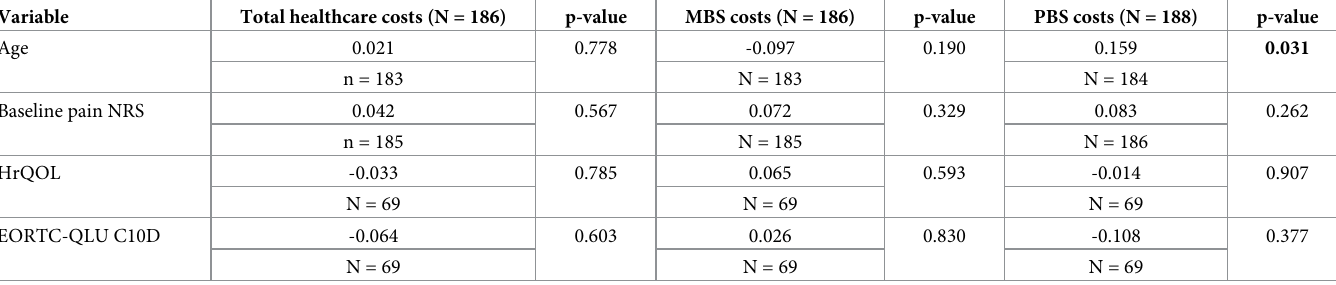
Table 4. Correlations between total healthcare, MBS and PBS costs and age, pain intensity and health-related quality of life. Variable